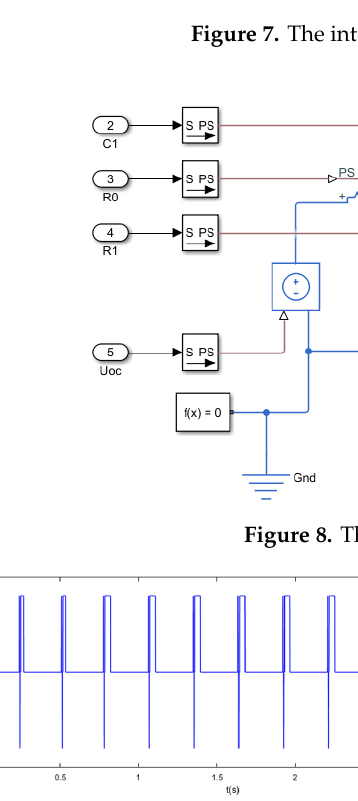
Figure 8. The internal structure of Thevenin model.